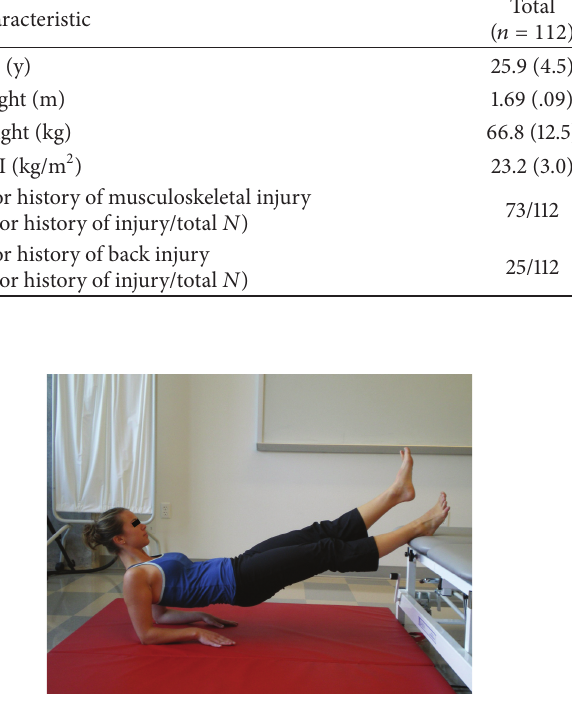
Figure 3: Posterior power line (PPL).